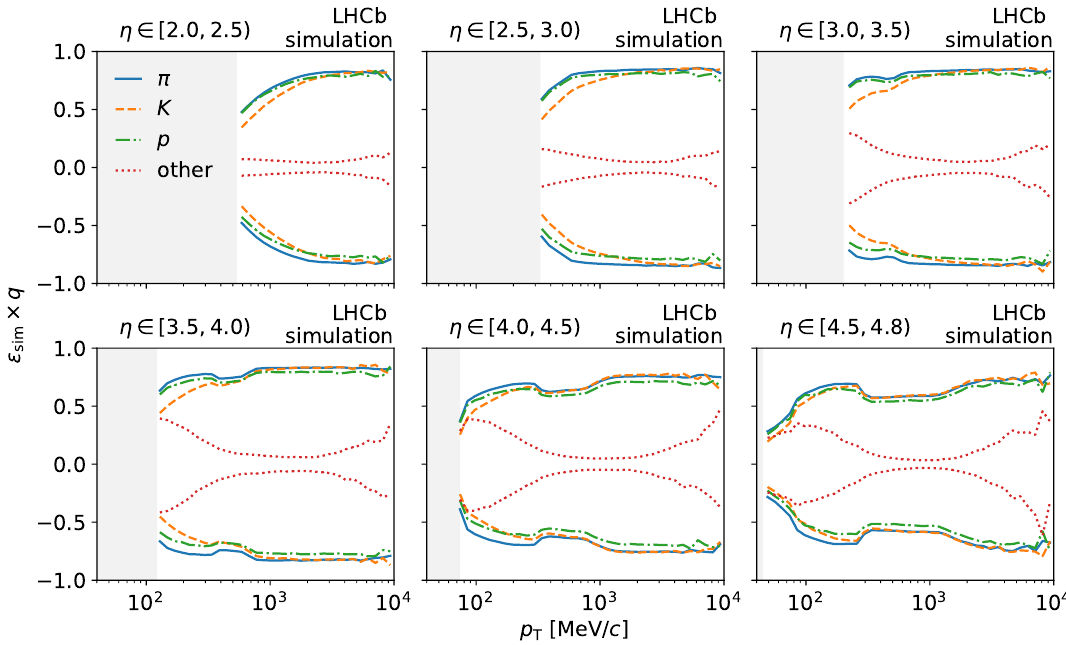
Figure 1 . Efficiencies for different particle species in intervals of η and as a function of p T for the simulated sample generated with the magnetic field pointing upwards. The product of the efficiency and the particle charge in units of the elementary charge is shown to separate values for oppositely charged particles. The light-grey areas indicate the limit of the kinematic